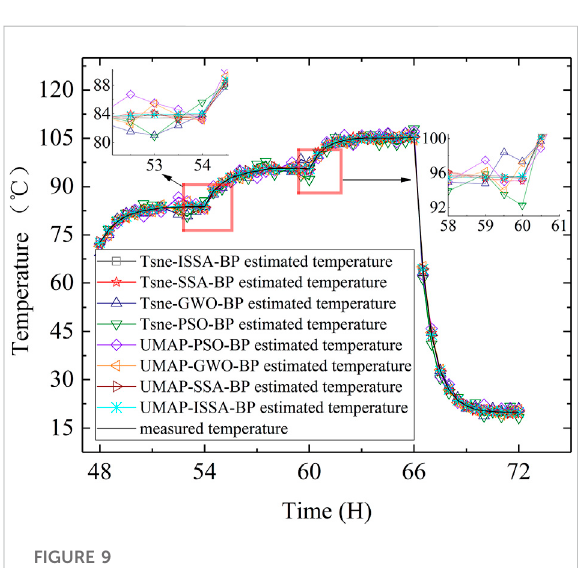
FIGURE 9 The comparison of inversion temperature and test temperature of BPNN improved by swarm intelligence algorithm after dimension reduction.